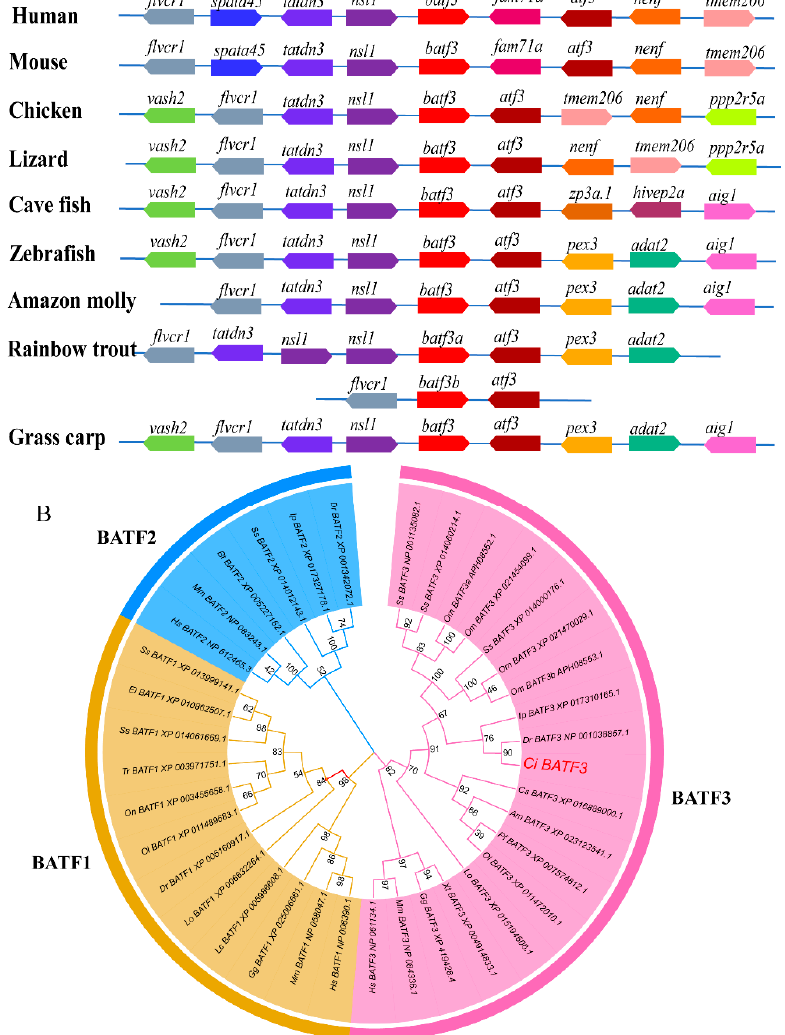
Figure 2. ( A ) Syntenic analysis of BATF3 gene in C. idella with different species. Gene synteny relationship of BATF3 genes were obtained by GnomicusV88.01 [34], and then these genes used as references were compared with grass carp genomic sequence. The syntenic analysis of BATF3 genes was performed with neighboring genes from other species. The arrows indicate the direction of transcription. Homologous genes are displayed in the same color. ( B ) The phylogenetic tree of BATF family genes. The phylogenetic tree of BATF3 was constructed by MEGA v 5.0 program based on neighbor-joining (NJ) method. Abbreviations of the species presented in the figure are as follows: Mus musculus (Mm), Oryzias latipes (Ol), Bos taurus (Bt), Takifugu rubripes (Tr), Gallus gallus (Gg), Xenopus tropicalis (Xt), Danio rerio (Dr), Oncorhynchus mykiss (Om), Homo sapiens (Hs), Poecilia formosa (Pf), Salmo salar (Ss), Latimeria chalumnae (Lc), Lepisosteus oculatus (Lo), Oreochromis niloticus (On), Esox lucius (El), Ictalurus punctatus (Ip), Cynoglossus semilaevis (Cs). The accession numbers are given after the species names in the tree.